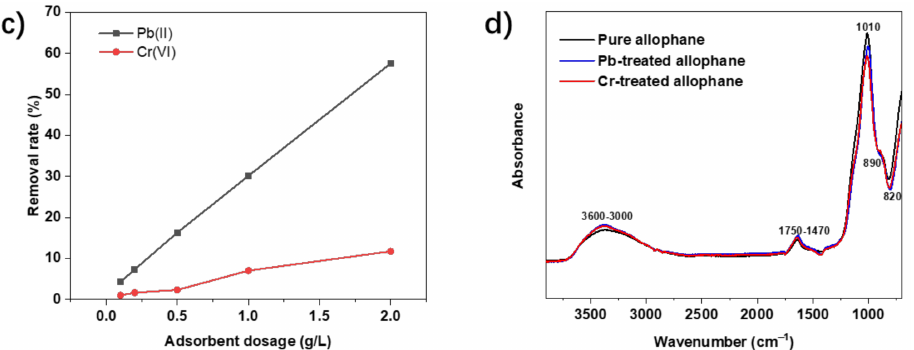
Figure 3. Effects of initial concentration of Pb 2+ and CrO 42 − onto synthetic allophane: ( a ) Contact time of 24 h, pH at 5; ( b ) Contact time of 24 h, pH at 2. ( c ) Effect of adsorbent concentration onto synthetic with an initial concentration of Pb(II) and Cr(VI): 200 mg/L and 10 mg/L, respectively; Pb(II) solution pH at 5, Cr(VI) solution pH at 2; and ( d ) FTIR spectra for synthetic allophanes before